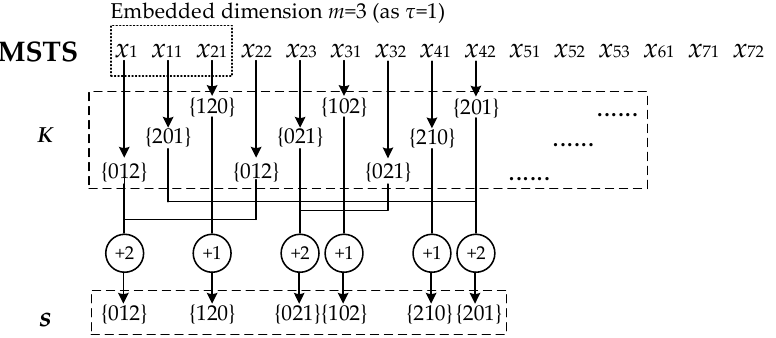
Figure 3. Generating the K from MSTS as m = 3, τ = 1.